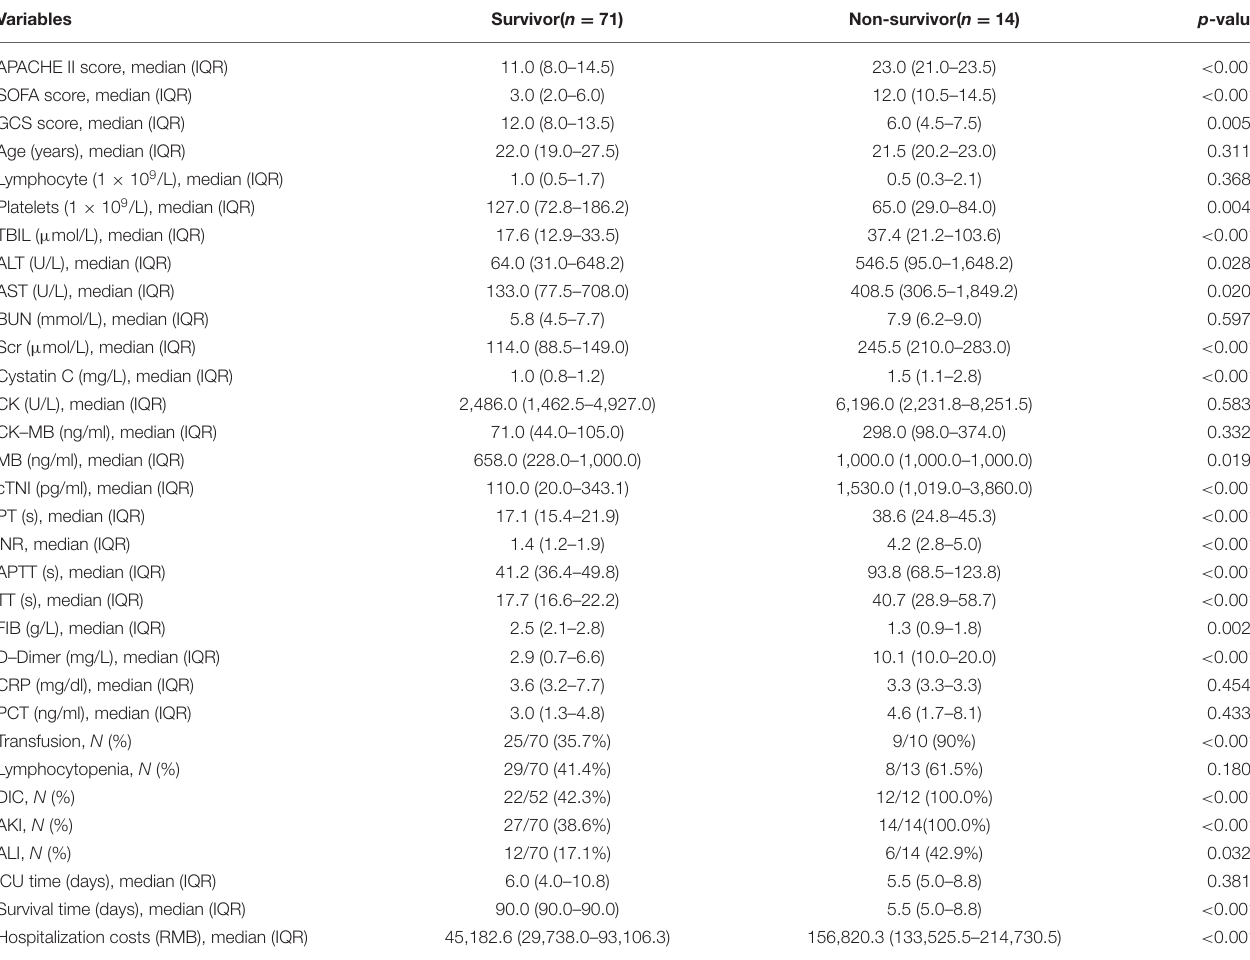
TABLE 2 | Comparisons of clinical characteristics between survivors and non-survivors with RM induced by EHS.